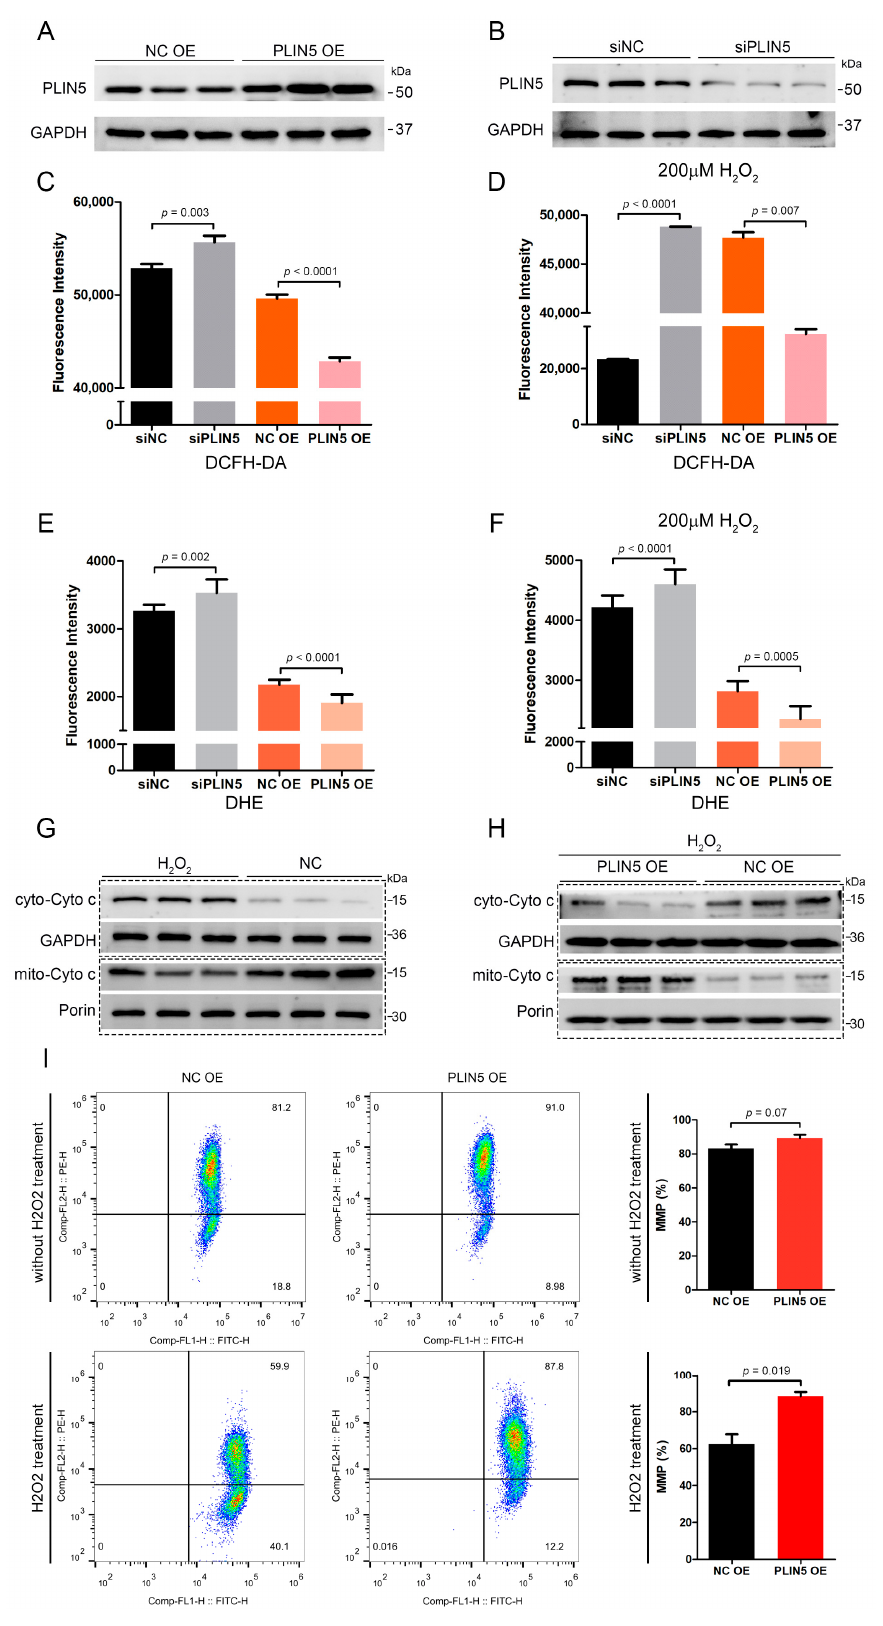
Figure 3. PLIN5 regulated cellular reactive oxygen species (ROS) levels. ( A,B ) Western blot validation of PLIN5 overexpression ( A ) and RNAi ( B ) efficiency. ( C ) HepG2 cells were transfected with PLIN5 siRNAs or negative control siRNAs or PLIN5 expression vector or pcDNA3.1 (control) vector, respectively.